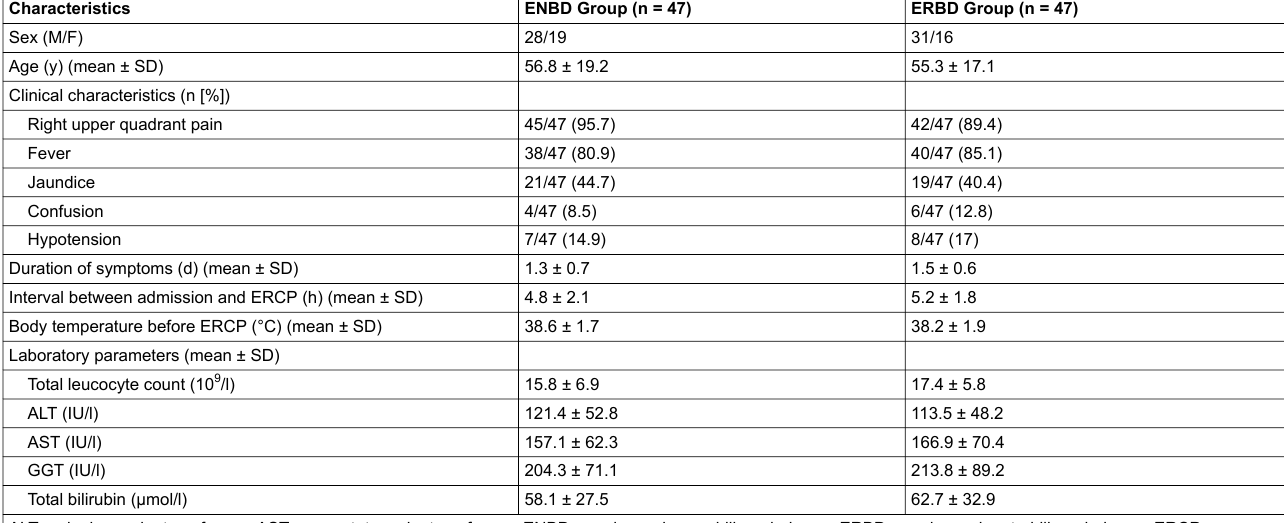
Table 1: Baseline demographic and clinical characteristics of the patients undergoing emergency ERCP. Characteristics